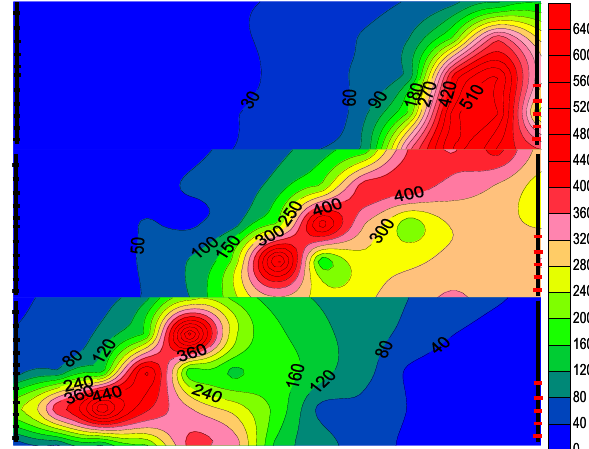
Fig. 6 The results of scanning electron microscopy on deposited oil sands